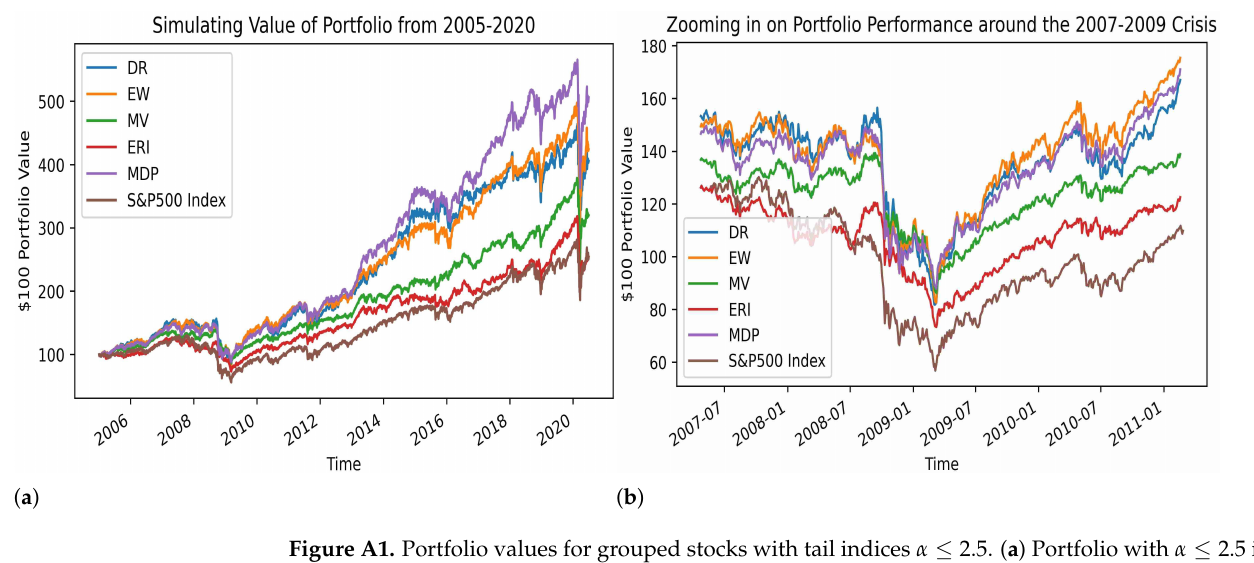
Figure A1. Portfolio values for grouped stocks with tail indices α ≤ 2.5. ( a ) Portfolio with α ≤ 2.5 in the entire backtest period; ( b ) portfolio with α ≤ 2.5 in the crisis period. Table A1. Performance comparisons for DR, EW, MV, ERI, MDP, and S&P 500 index for stocks with α ≤